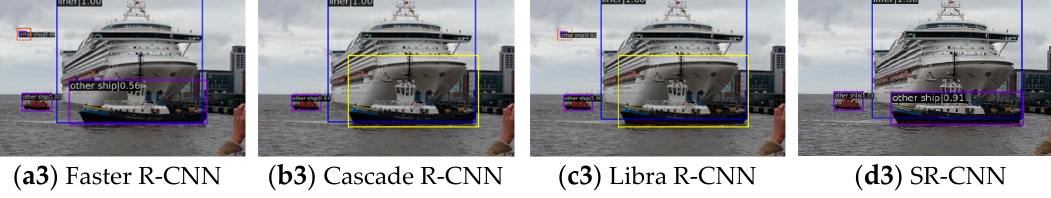
Figure 12. Comparison of ship detection algorithms in nearshore complex background. (Orange box is incorrect ship detection and yellow box is missed ship target).